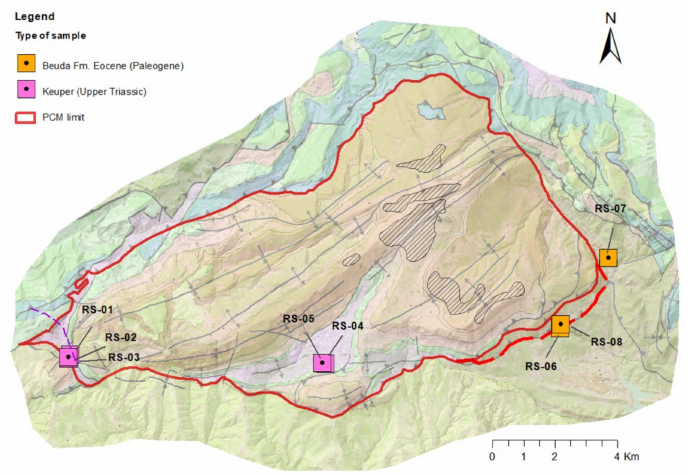
Figure A1. Map of rock samples collected for the characterization of S and O isotopes from sulfate content in Triassic and Tertiary gypsum in the PCM.